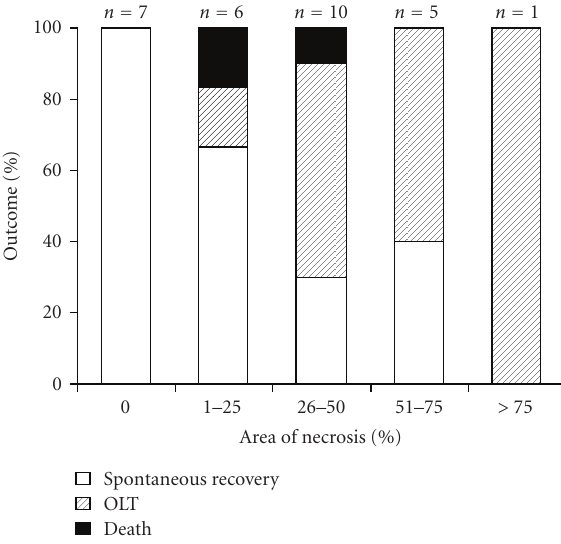
Figure 3: Hepatocellular necrosis in acute/subacute liver failure. More than 25% of hepatocellular necrosis was associated with a poor transplant free